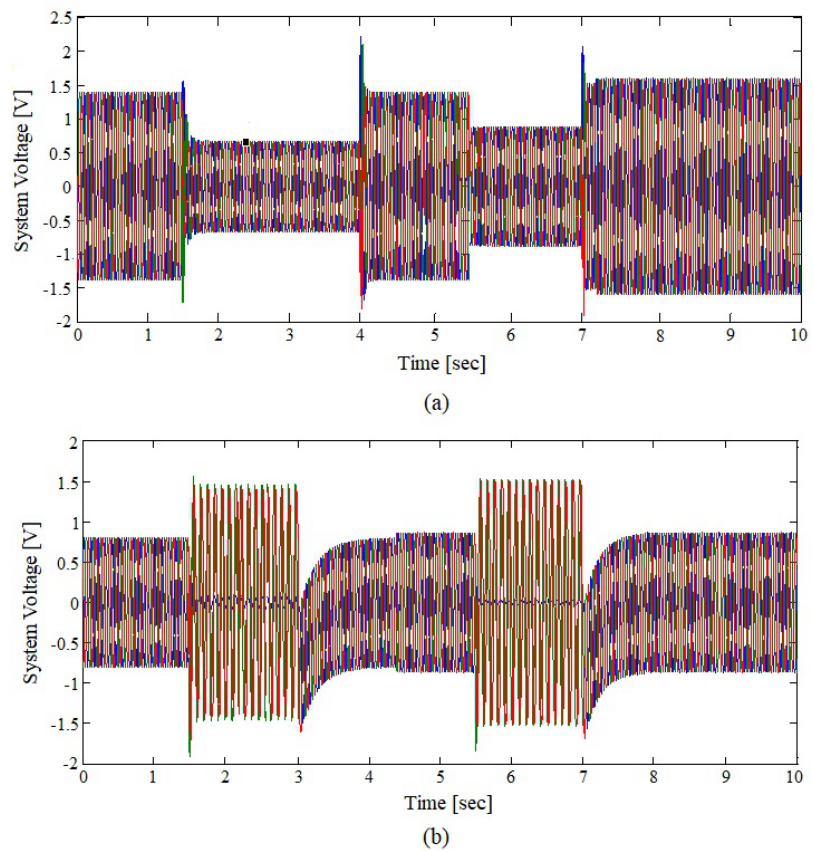
Figure 11. Voltage profile with and without DG under normal and faulty scenarios, ( a ) three phase (symmetrical) fault at F2 (forward) and ( b ) single phase to ground (asymmetrical) fault at F1